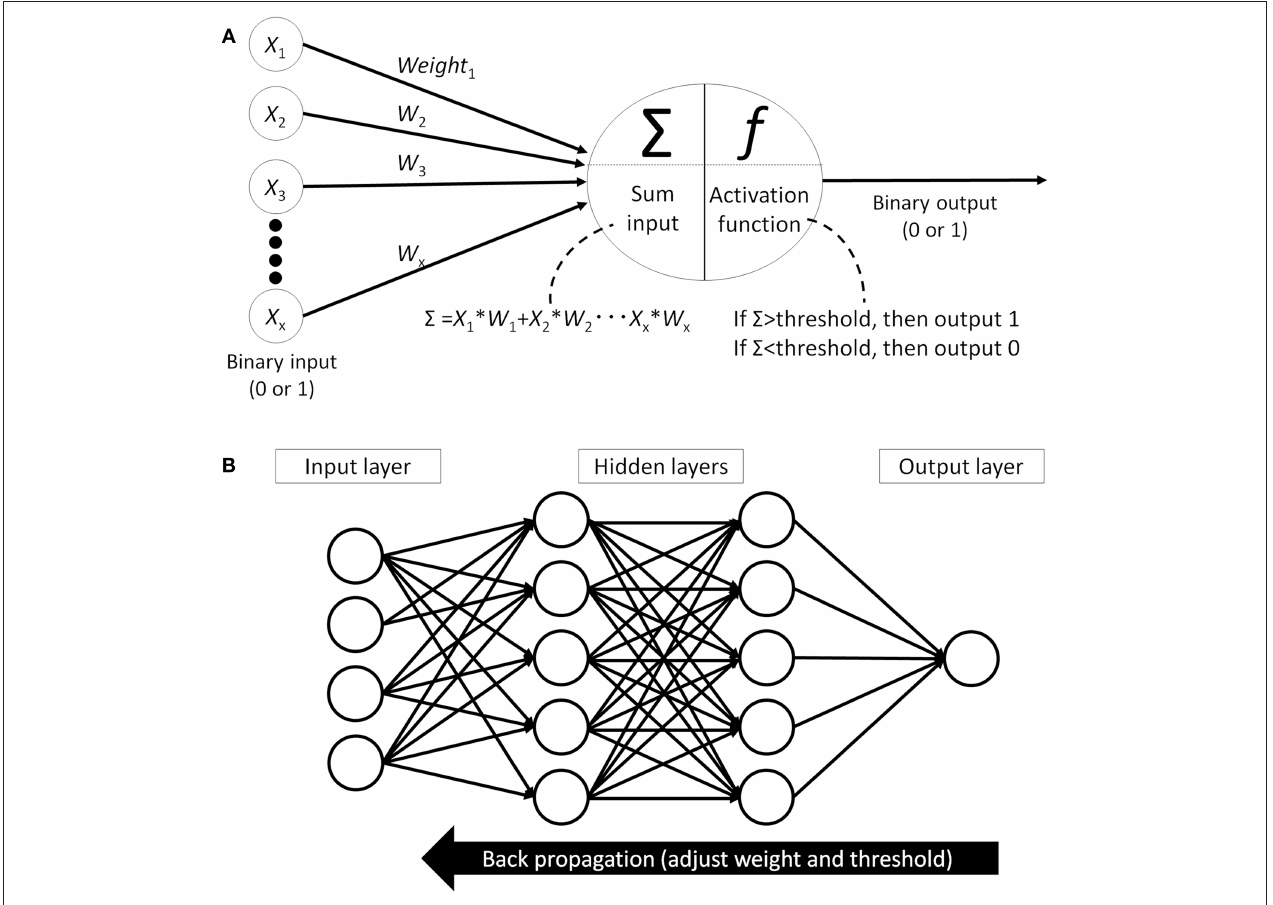
FIGURE 4 | Artificial neural network (ANN). (A) Single perceptron model which mimics the structure of biological neural networks in the human brain. Each node receives signal from other nodes (X1, X2… Xx). Add the multiplied values of input and weight (W) and when this sum( 6 ) cross the threshold, then this node outputs signal. (B) An example of artificial neural network model which has hidden layer between input layer and output layer. All the nodes between the layers are fully connected and each connection has weight. Machine learning is adjusting each weights and thresholds in the network to reach the correct output (back